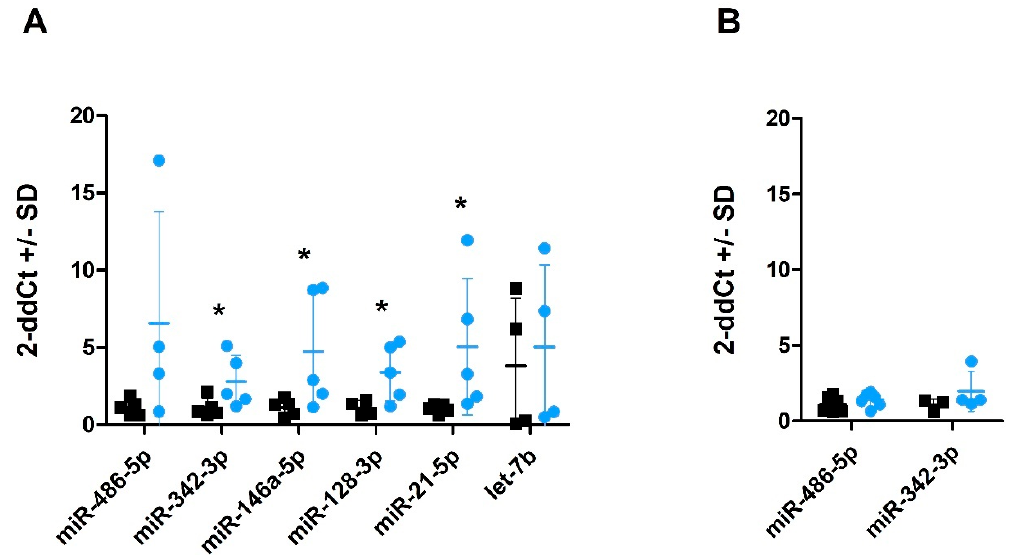
Figure 4. Quantification of miRNAs in CSF and CSF-derived sEVs by qPCR. Fold change of miRNAs in total CSF ( A ) and sEVs derived from CSF ( B ) of scrapie sheep (blue circles) compared with control sheep (black squares). Data are expressed as a relative expression value after 2 −ΔΔ Ct conversion using the mean of healthy control sheep as a calibrator, +/ − standard deviation (SD). Statistical significance was assessed by Student’s t -test (* p < 0.05). sEVs were isolated using the Exiqon kit.